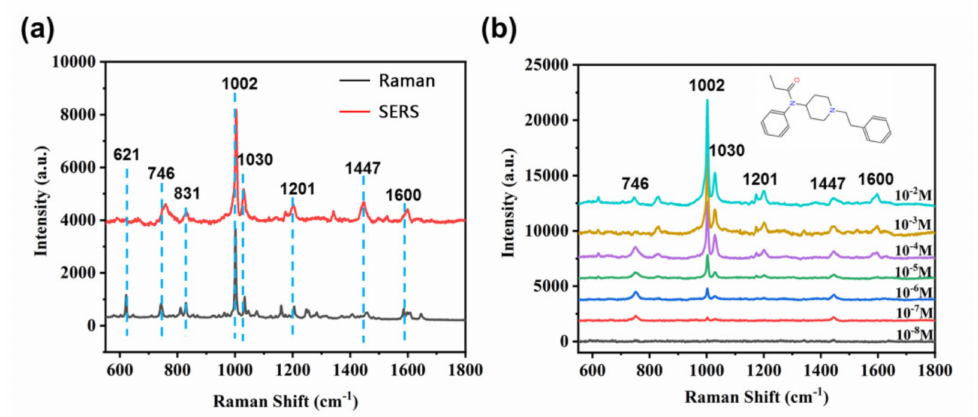
Figure 5. ( a ) Normal and surface-enhanced Raman spectra for fentanyl (10 − 4 M). ( b ) SERS spectra of fentanyl at different